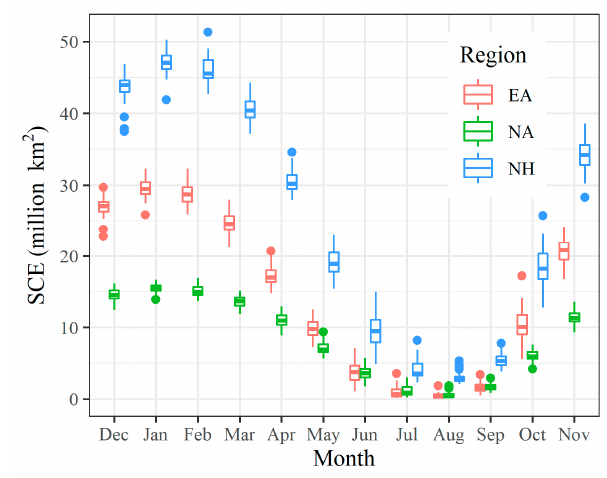
Figure 2. Boxplots of monthly variability in SCE (1967–2018) of NH, EA, and NA. The horizontal line in the box is medium value. The upper and lower boundary of box is the first quartile and the third quartile, respectively. Dots are outliers (more or less than twice standard deviations).